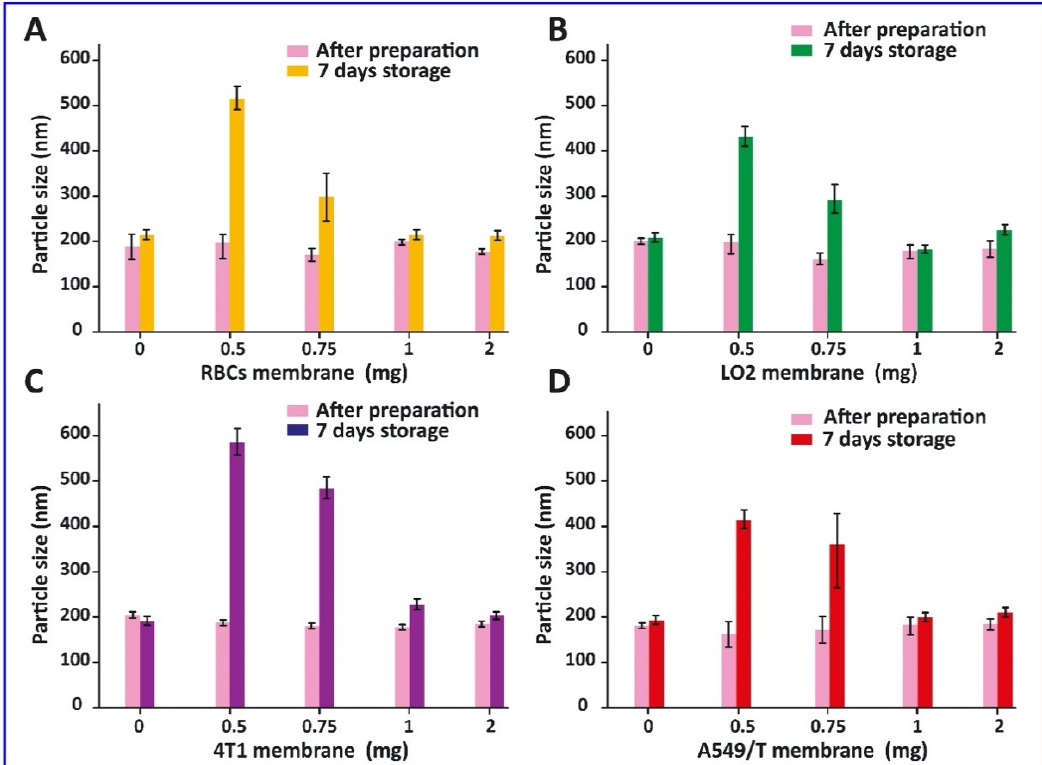
Figure 4. Membrane-coating optimization. Hydrodynamic size of ( A ) RBC CM-HNPs, ( B ) LO2 CM-HNPs, ( C ) 4T1 CM-HNPs, and ( D ) A549/T CM-HNPs at various weight ratios of membrane protein and nanoparticle after synthesis and after 7 days storage in PBS (pH 7.4); n = 3.